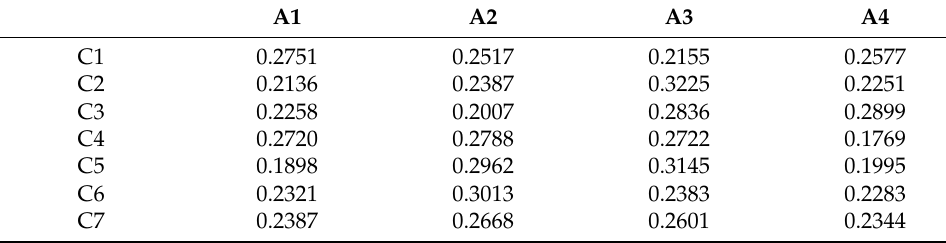
Table 5. The normalized decision matrix for selecting a third-party logistics